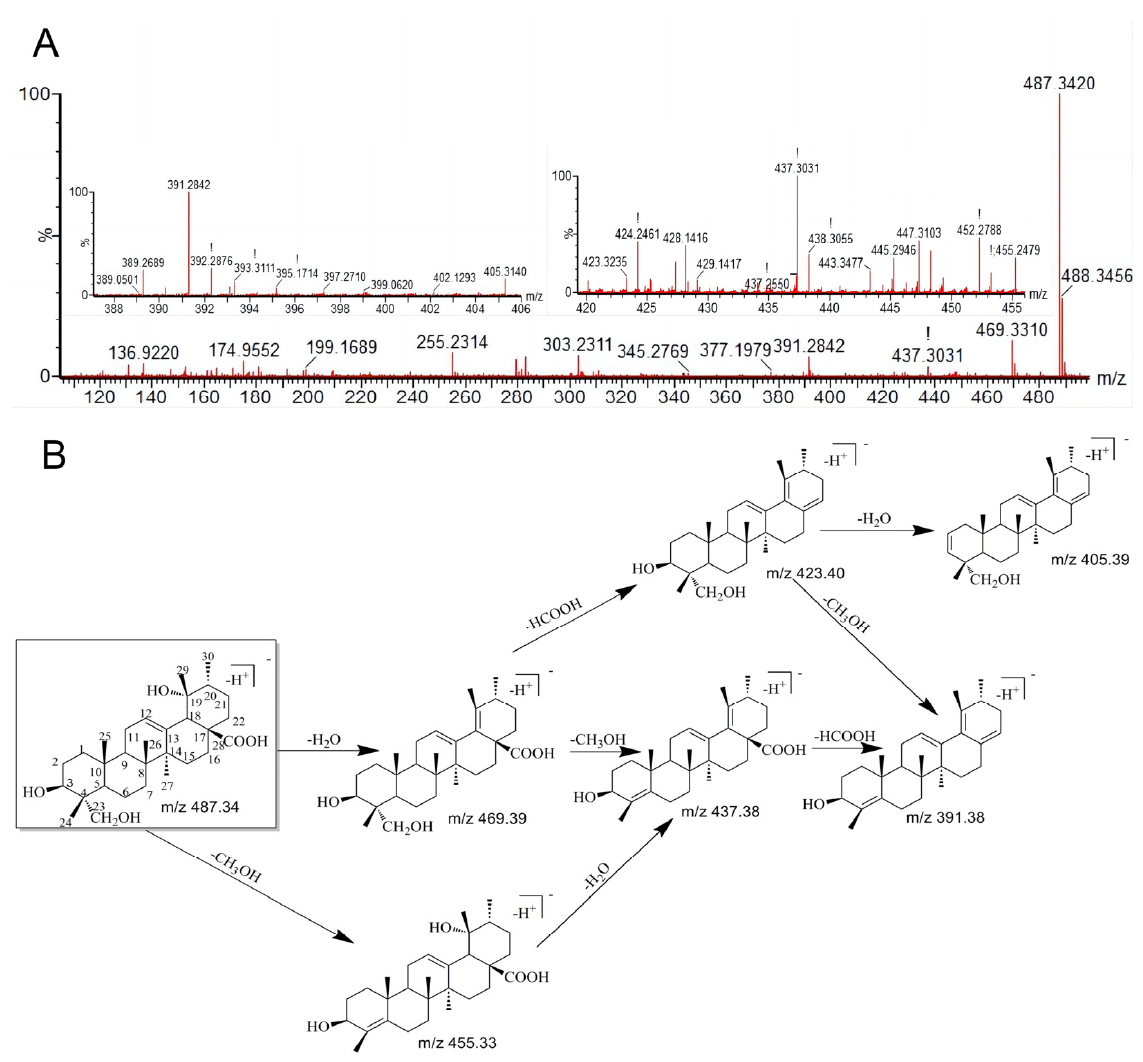
Figure 2. The MS 2 spectra of RA ( A ) and the proposed fragmentation process of RA ( B ). “!”indicates there may be interference with the shape or resolution of the particular MS peaks. It usually appears on the magnified Masslynx mass specta. For known chemical structures, these molecular ions can be manually